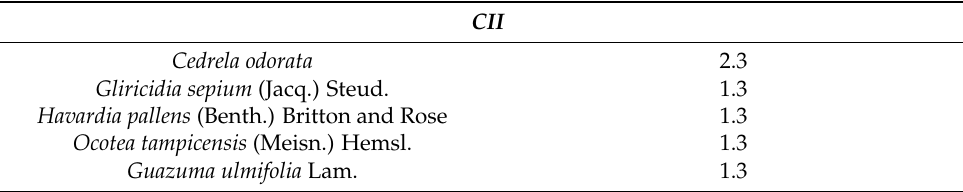
Table 4. Cultural Importance Index ( CII ) results.